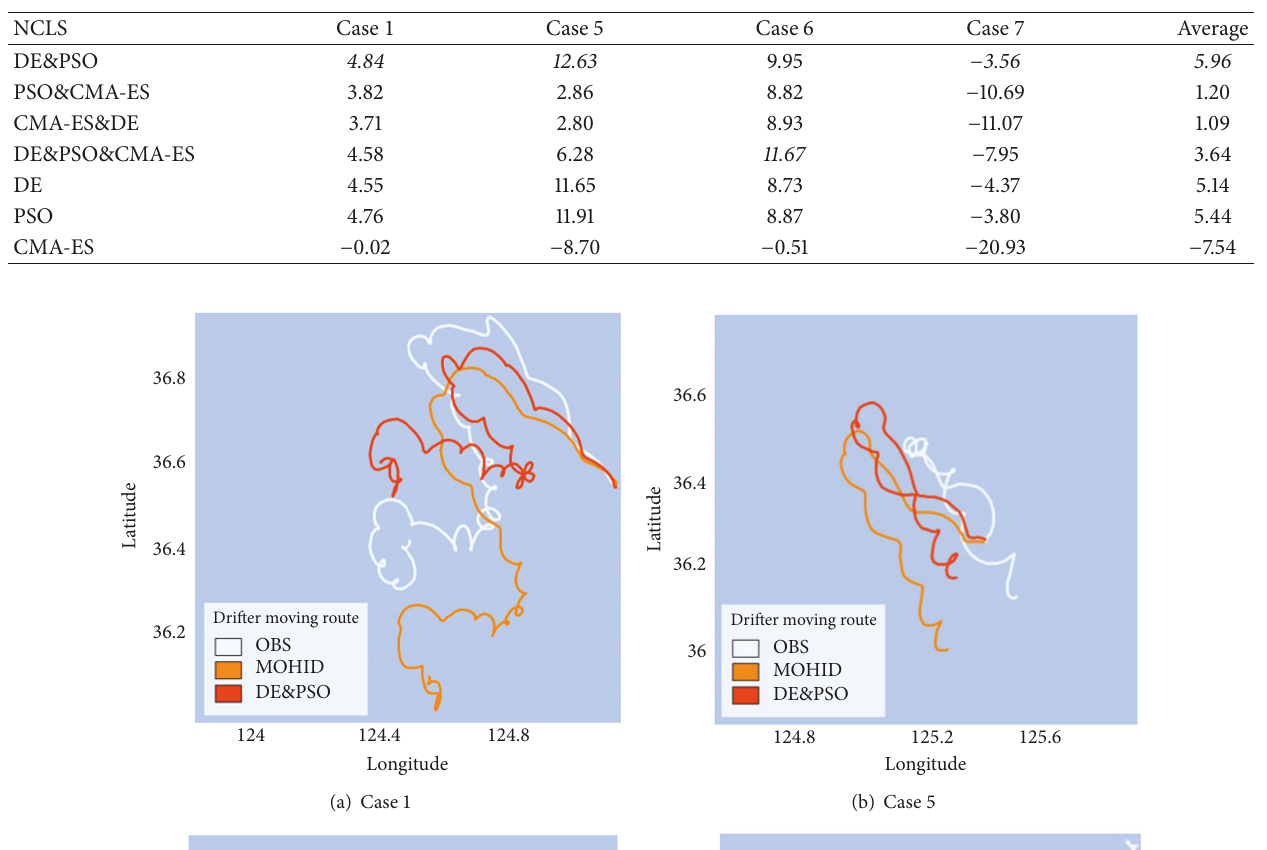
Table 15: Performance improvement with respect to NCLS (%).